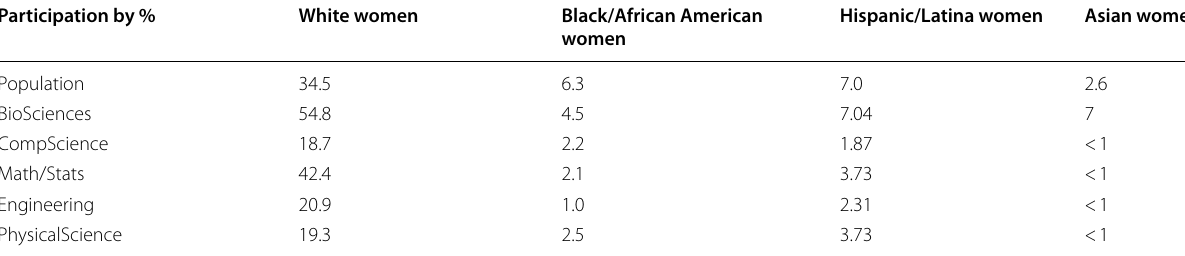
Adapted from “2019 women, minorities, and persons with disabilities in science and engineering report”, by the National Science Foundation, National Center for Science and Engineering Statistics. 2019. Women, Minorities, and Persons with Disabilities in Science and Engineering: 2019. Special Report NSF 19 –304. Alexandria, VA. (https:// www. nsf. gov/ stati stics/ wmpd). Copyright 2019 by